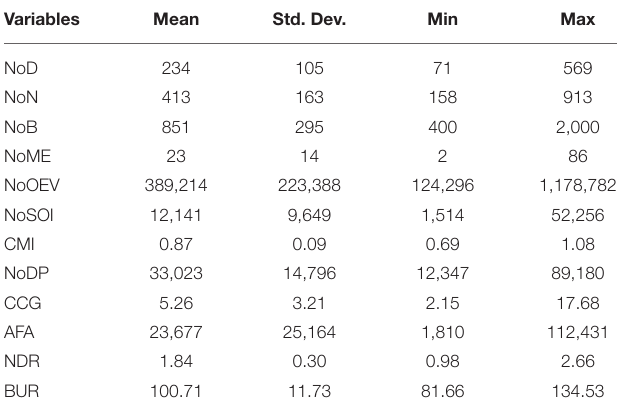
TABLE 2 | Descriptive statistics of variables. FIGURE 2 | Technical efficiency score distribution radar